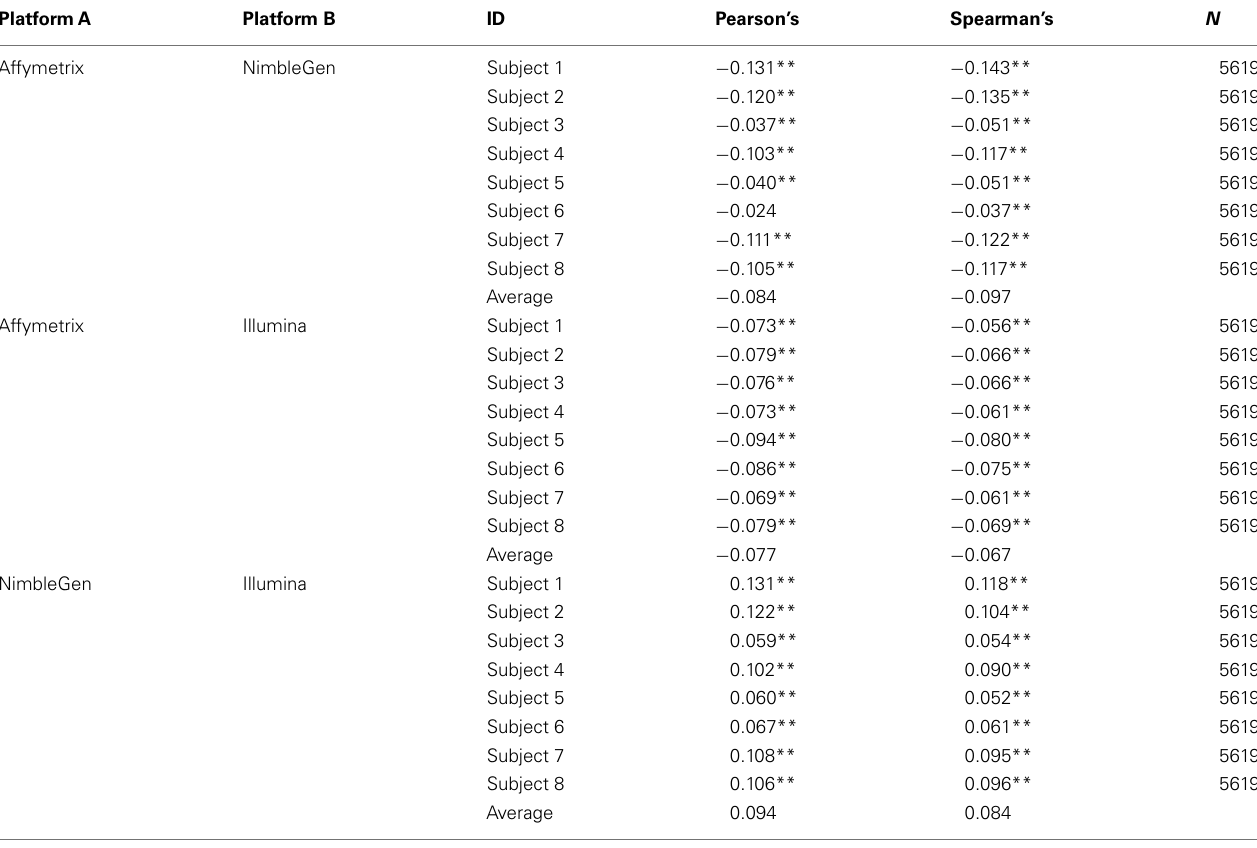
Table 2 | Correlation of methylation and gene expression